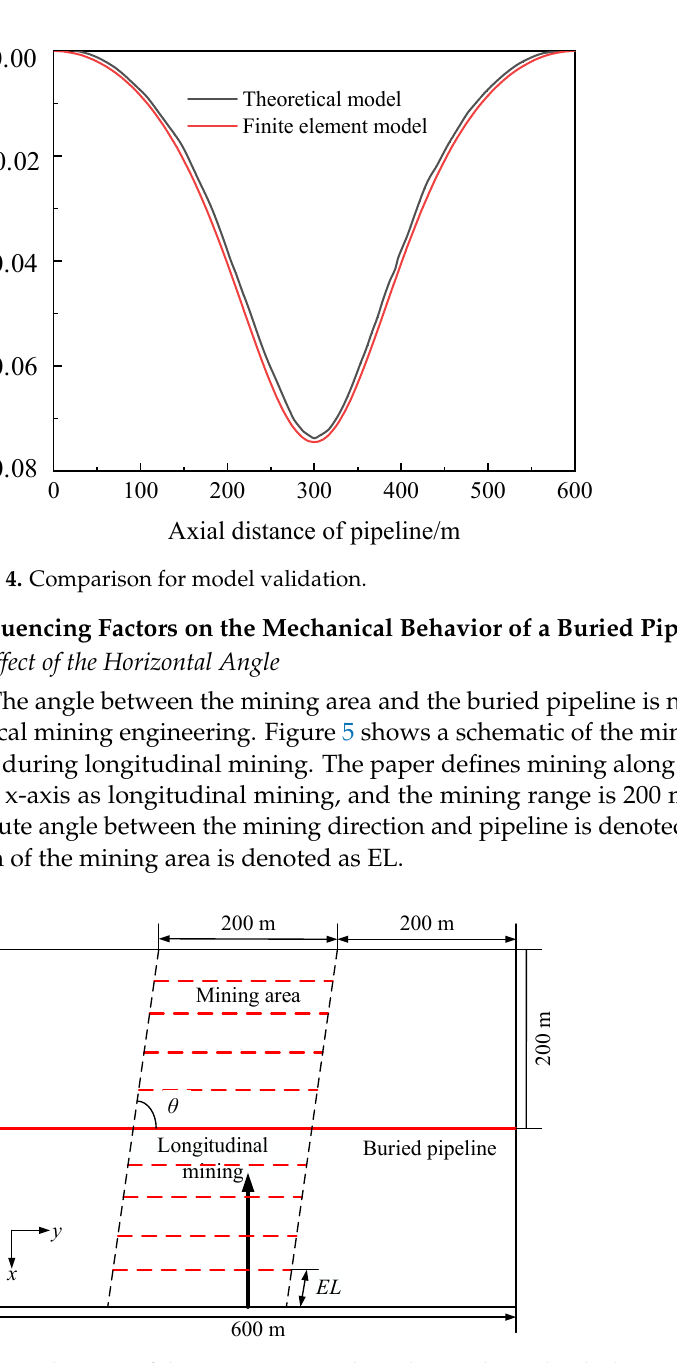
Figure 5. Schematic of the mining area and pipeline strike under the longitudinal mining condition.